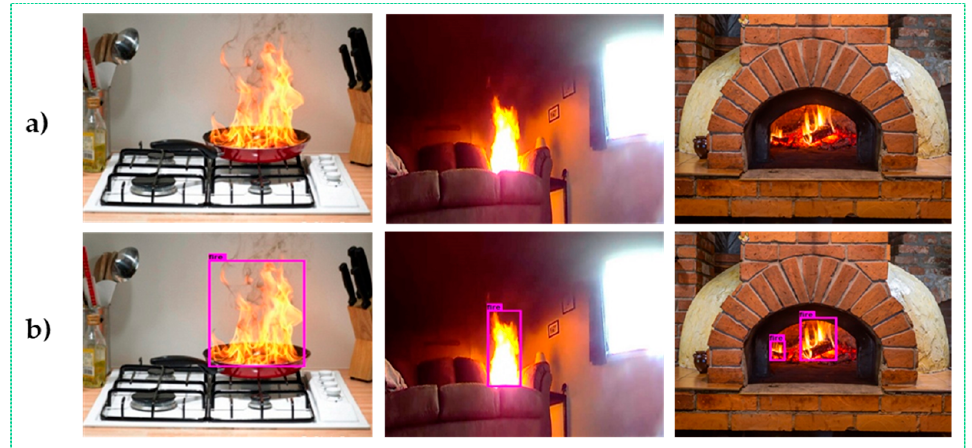
Figure 5. Results of the experiment that may be observed in daytime fire scenarios include the ( a ) input image sequences and the ( b ) output image sequences with fire regions detected.